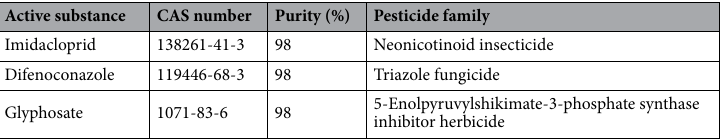
Table 1. Characteristics of the